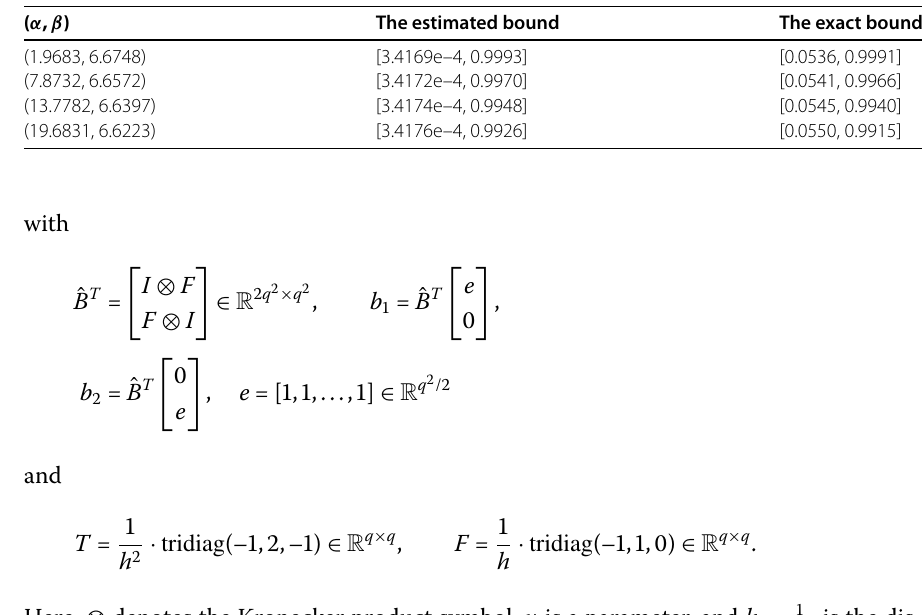
Table 1 Bounds of nonzero real eigenvalues of the preconditioned matrix P –1 Example